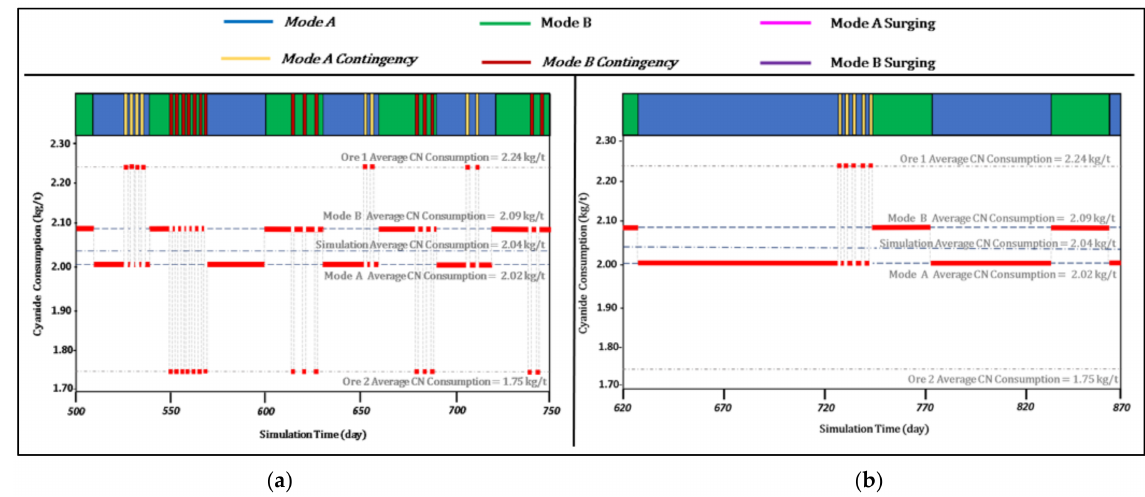
Figure 9. Cyanide consumption simulation plots based on modes of operation, relative ore proportions, and average consumption requirement for each ore type (Ore1 = 2.24 kg/t, Ore 2 = 1.75 kg/t). ( a ) Simulation trial using a TOSL of 4000 t and COSL of 3000 t, showing the constant cyanide dose adjustment as a function of the short time frames between each operational mode change due to system instability. ( b ) Simulation trial using a TOSL of 10,000 t and COSL of 2000 t, showing a flat cyanide dose (greater system stability) as a function of the longer time frames spent in Mode